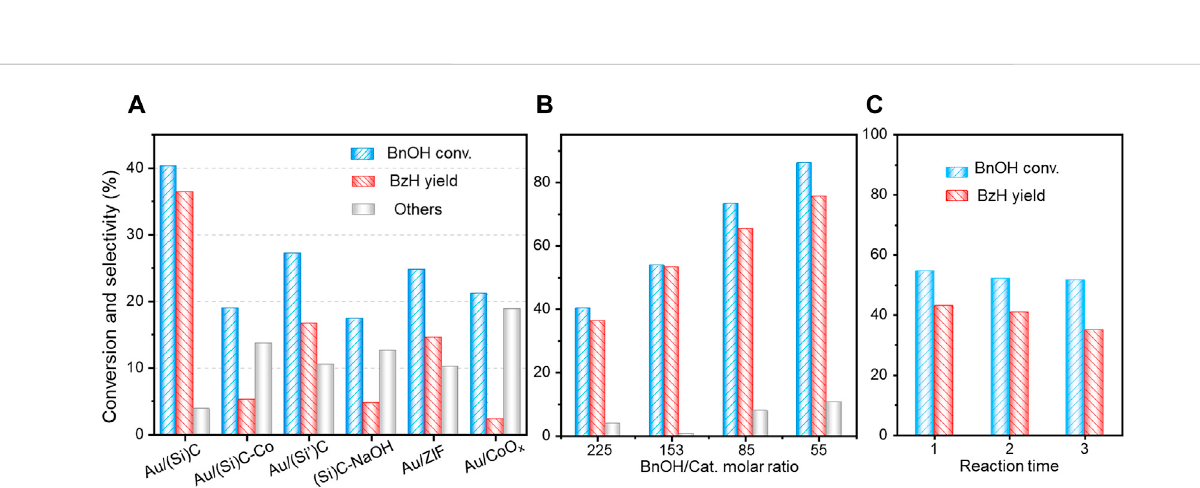
XPS spectra of the (A) Au 4 f , (B) Co 2 p , and (C) O 1 s core levels of (Si)C-NaOH after NaOH etching and Au/(Si)C with gold loading.